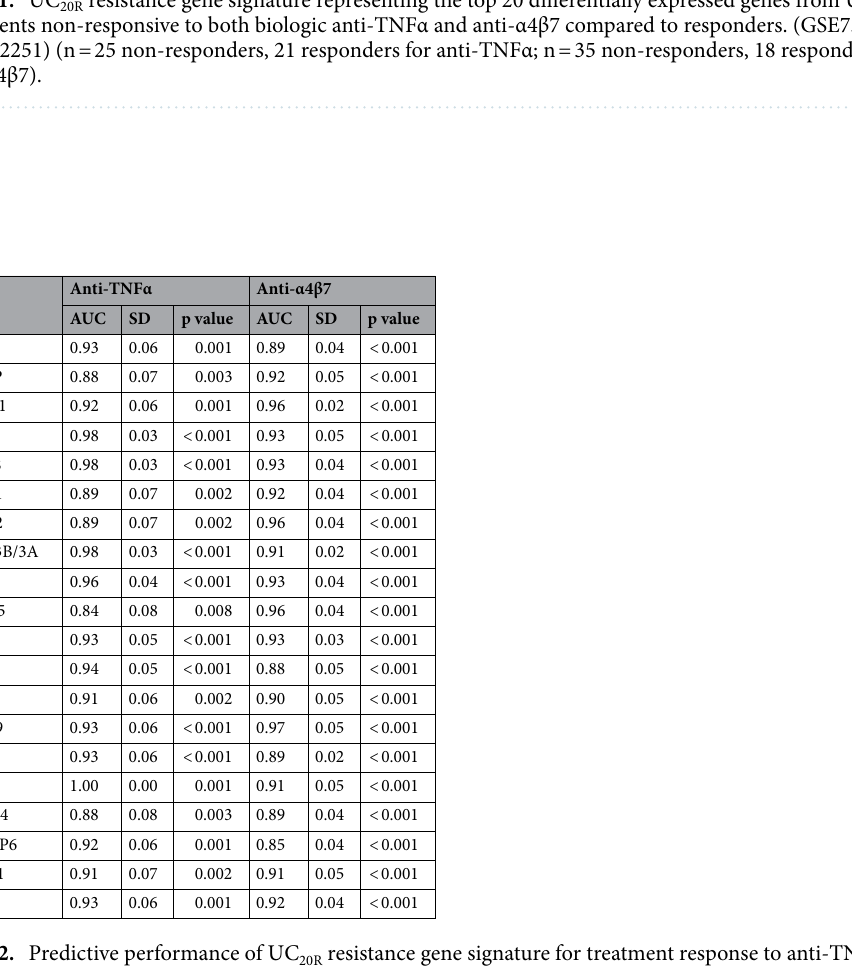
Table 2. Predictive performance of UC 20R resistance gene signature for treatment response to anti-TNFα and anti-α4β7. (GSE73661, GSE12251) (n = 25 non-responders, 21 responders for anti-TNFα; n = 35 non- responders, 18 responders for